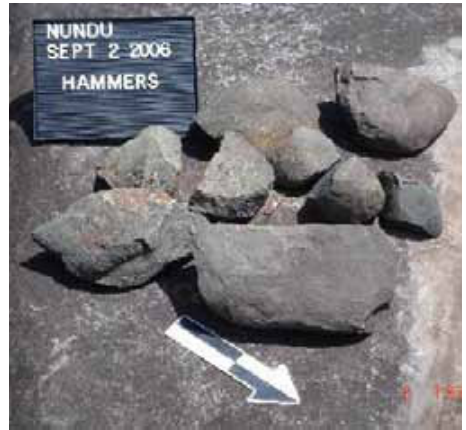
Fig 12: The big basaltic anvil and the stone hammers of Nundu ST1.